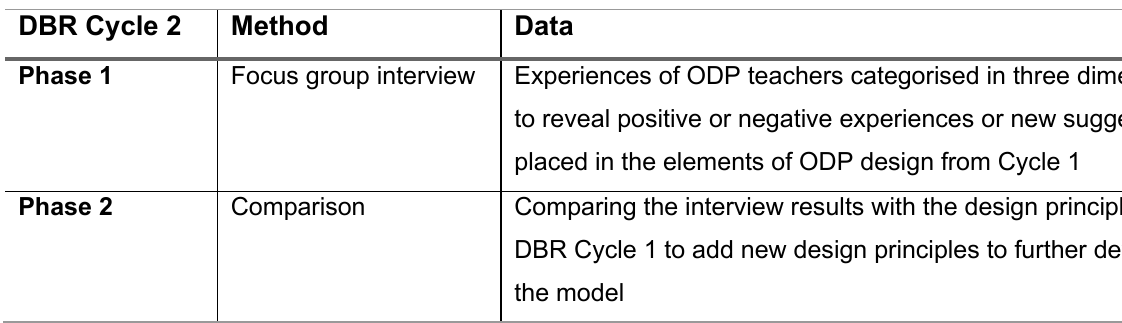
Methods and focus of data collection in DBR Cycle